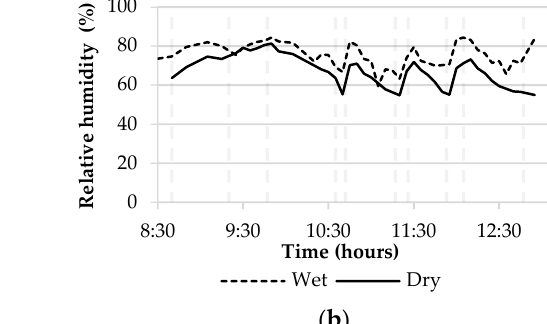
Figure 13. Average of the readings of sensors placed in crates with produce watered previously to being loaded, versus the readings of dry crates for temperature ( a ) and relative humidity ( b ).